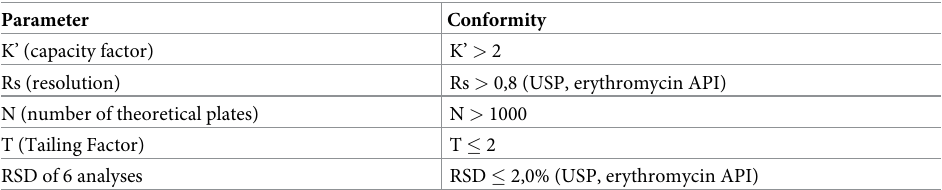
Table 4. System Suitability Test for erythromycin dosing